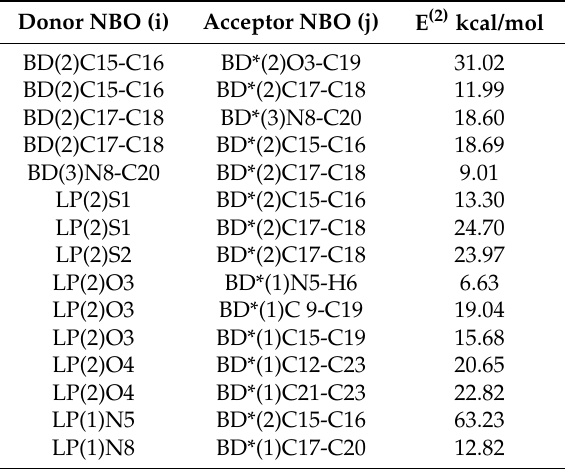
a Atoms’ numbering according to Figure 3.